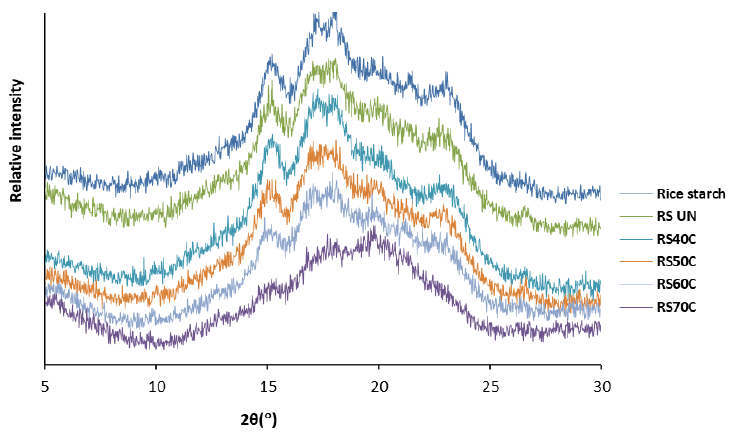
Figure 4. X-ray diffraction patterns of native rice starch and resistant starches (RS) isolated from rice bran that was untreated (UN) and ultrasonicated (1.8 W/cm 2 , 20 min) at different temperatures.